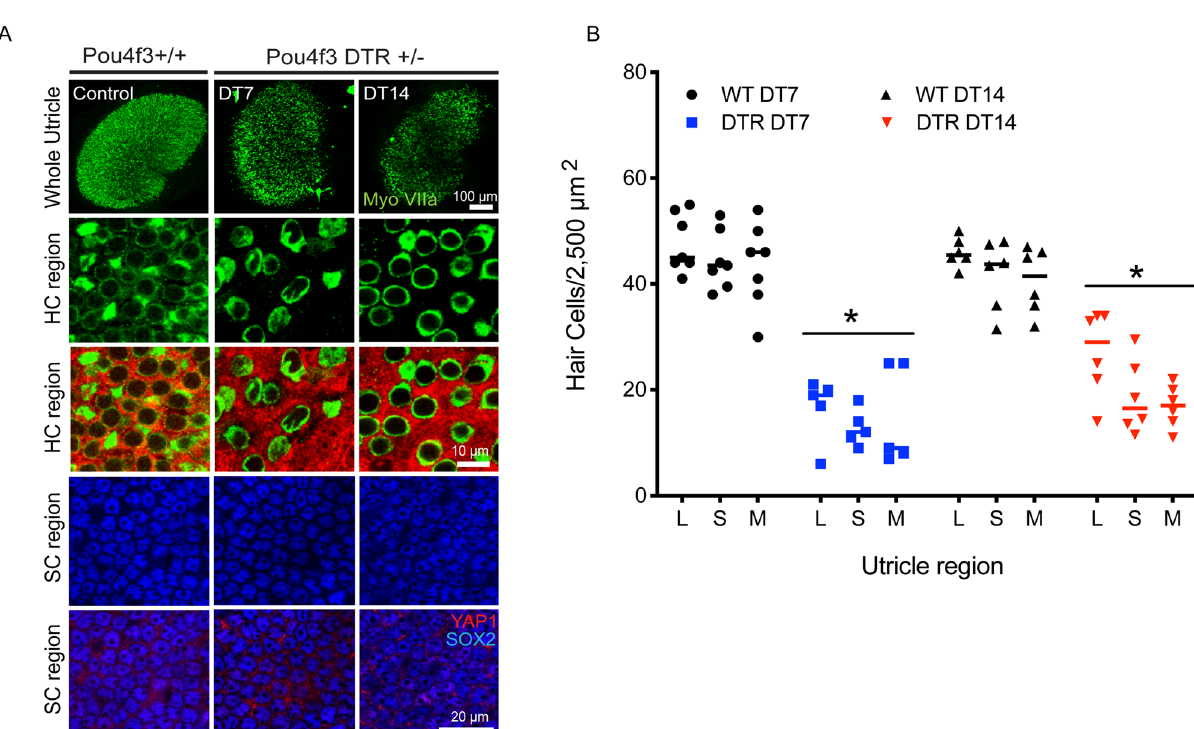
Figure 4. Nuclear translocation of YAP1 was not observed after diphtheria toxin (DT)-mediated hair cell lesions. ( A ) Adult Pou4f3 + / + and Pou4f3 + /DTR mice were injected with a single dose of DT (25 ng/g i.p). After 7 (DT7) or 14 (DT14) days recovery, utricles were collected, fixed and immunolabeled for myosin VIIa (green), SOX2 (blue) and YAP1 (red). Confocal images of wholemount utricles from Pou4f3 + / + (wild type control, at DT14) and Pou4f3 + /DTR at DT7 and at DT14 are shown in the top row. Images from the hair cell region and supporting cell region are shown in the second and third rows, and fourth, and fifth rows, respectively. Treatment with DT led to reduced hair cell numbers (green) and increased area of YAP1 positive (red) labeling in Pou4f3 + /DTR mice at DT14 and DT7, as compared to wild type controls. ( B ) Quantitative data on hair cell density after a single dose of DT (25 ng/g i.p). All data were obtained from 50 X 50 µm regions within the lateral extrastriolar (L), striolar (S) and medial extrastriolar (M) regions of each utricle. There was a significant decrease in hair cell numbers at DT7 and DT14, compared to controls (p < 0.0001). However, as shown in ( A ), this hair cell loss did not lead to YAP1 immunoreactivity in the nuclei of supporting cells. Data expressed as mean ± SD. Statistical tests used two-way ANOVA followed by Tukey’s post hoc test (*p value < 0.05, relative to P0). N = 4–6